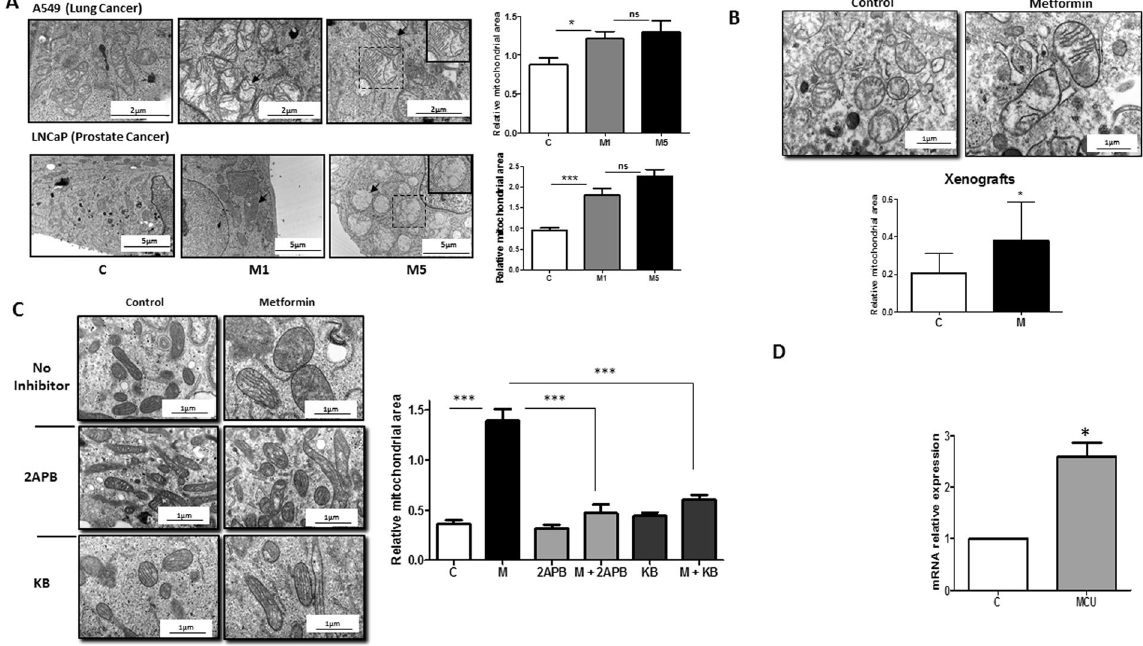
Figure 2. Metformin induces mitochondrial swelling in cancer cells in vitro and in vivo . ( A ) Electron microscopy (EM) of LNCaP (PCa) and A549 (lung cancer) cells treated with 1 and 5 mM metformin for 24 h. The graphs represent the mean of the relative mitochondrial area. An example of swollen mitochondria with modifications of the IMM is noted with an arrow. The inset shows a magnified view of a representative mitochondrion. ( B ) Electron microscopy images of representative mitochondria from tumor xenografts, and quantification of the relative mitochondrial area in the corresponding tumors. The error bars represent the standard error of the mean (sem). ( C ) Electron microscopy images of LNCaP cells treated with metformin and 40 µ M 2-ABP or 10 µ M KB-R7943 for 24 h. Quantification of the mitochondrial area is reported in the graph (left panel). For each condition, 60 to 100 mitochondria from several cells were analyzed by EM. ( D ) Quantification of MCU mRNA in LNCaP cells treated with metformin for 24 h. The differences are significant with p < 0.05 ( * ) and p < 0.001 ( ***